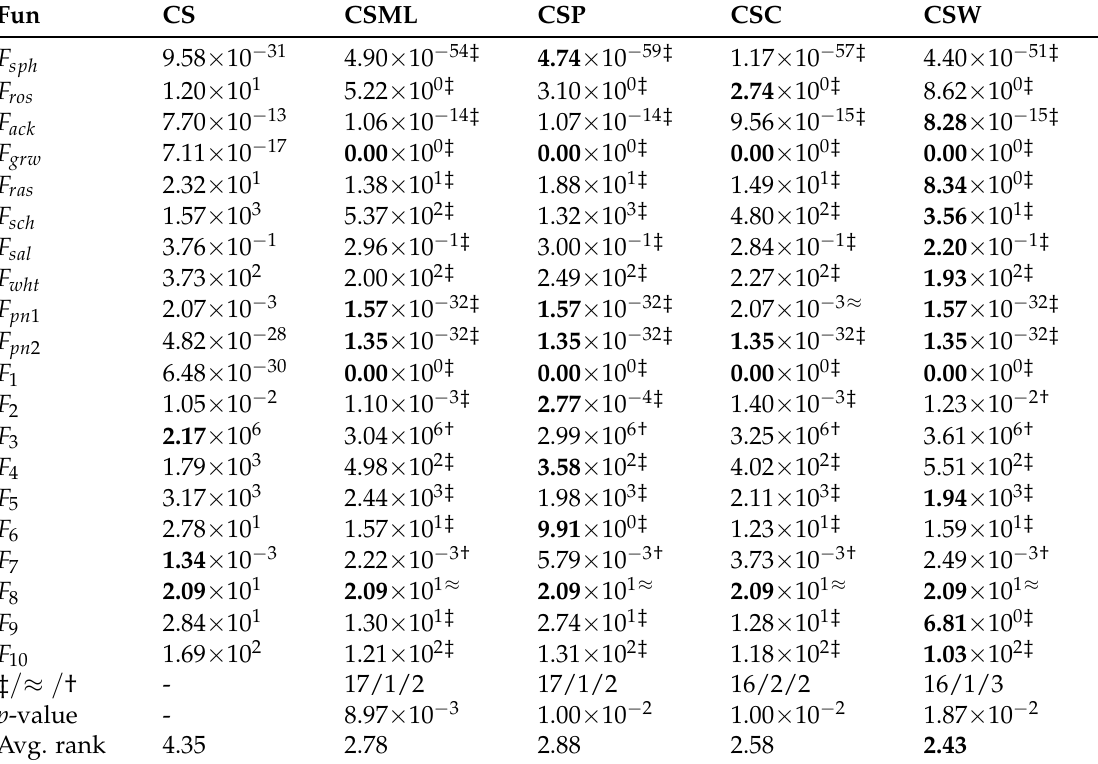
Table 2. Comparisons between CS and four randomness-enhanced CS algorithms at D =